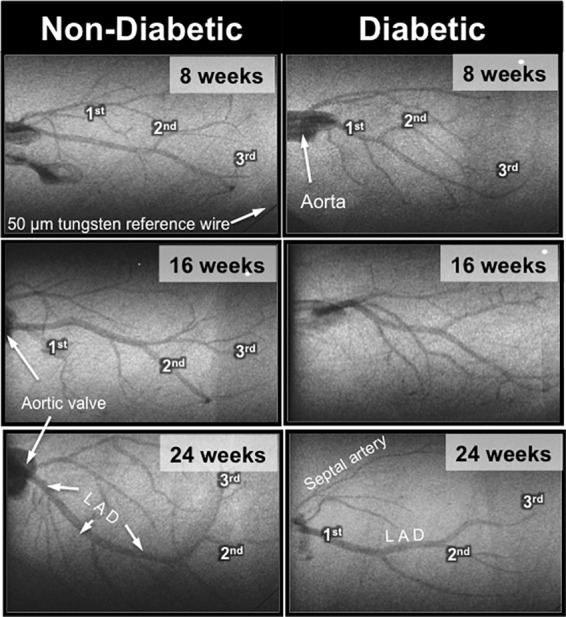
Representative microangiogram images showing the contrast-enhanced coronary arterial branching network down to the 3rd order in anesthetized db/db non-diabetic (Left) and db/db diabetic (Right) mice at 8, 16, and 24 weeks of age. The tungsten wire in the bottom right corner of both angiogram frames is a reference of 50 μm diameter.